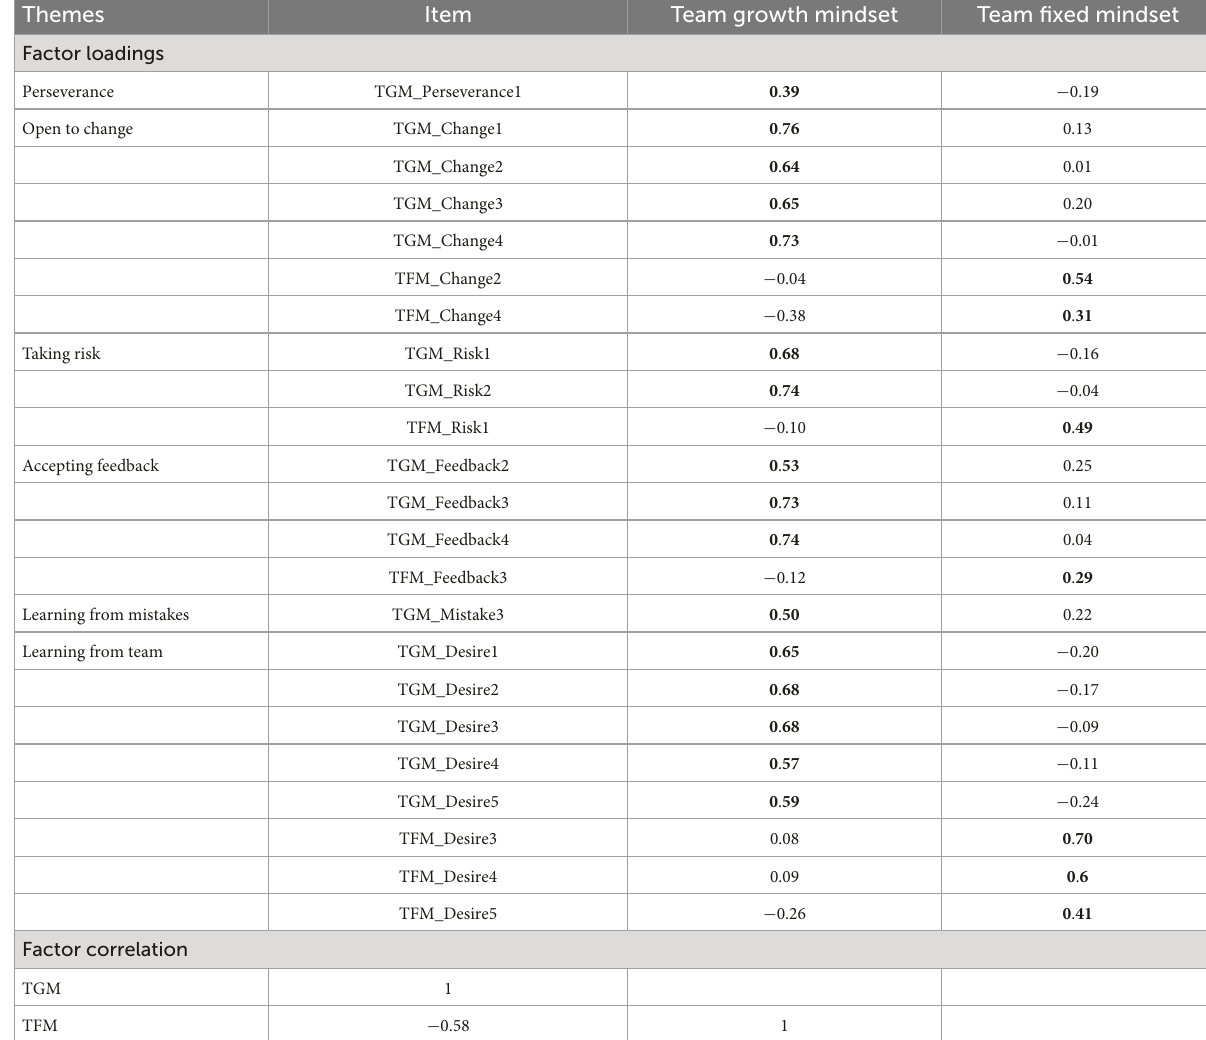
TABLE 1 Factor loadings and factor correlation from exploratory factor analysis